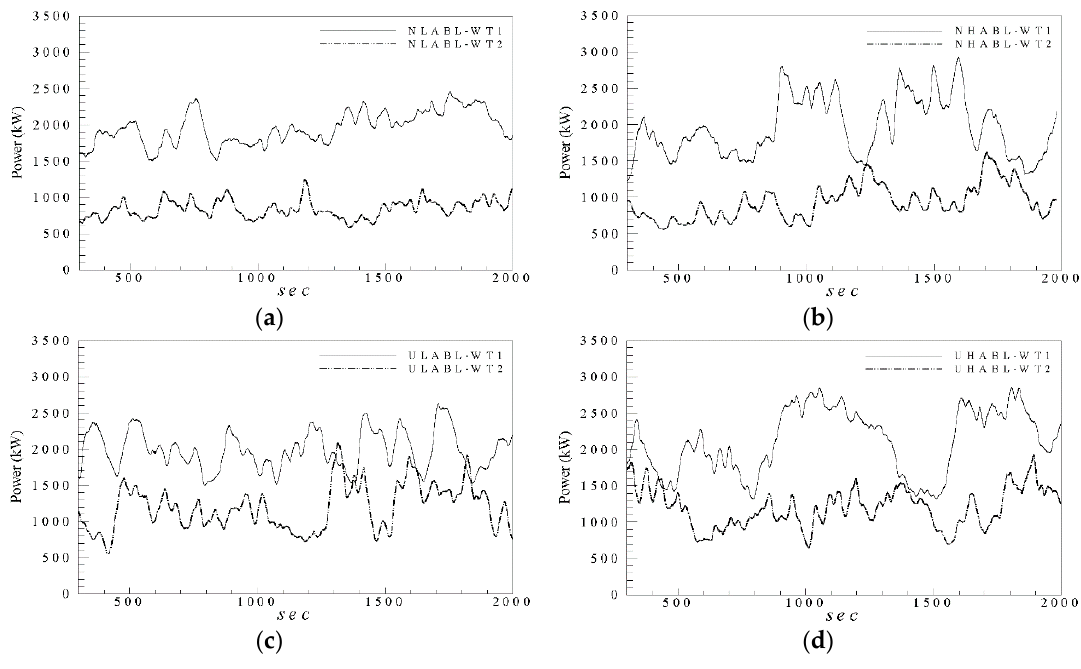
Figure 11. Time series of the power signals for upstream (WT1) and downstream (WT2) turbines: ( a ) NLABL, ( b ) NHABL, ( c ) ULABL, and ( d ) UHABL. Refer to Table 1 for acronyms.